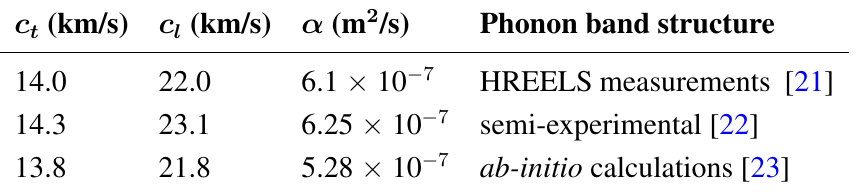
Table 3. Slopes c and c of the TA and LA phonons of graphene at the (cid:0) point and quadratic t l coefficient (cid:11) of the ZA